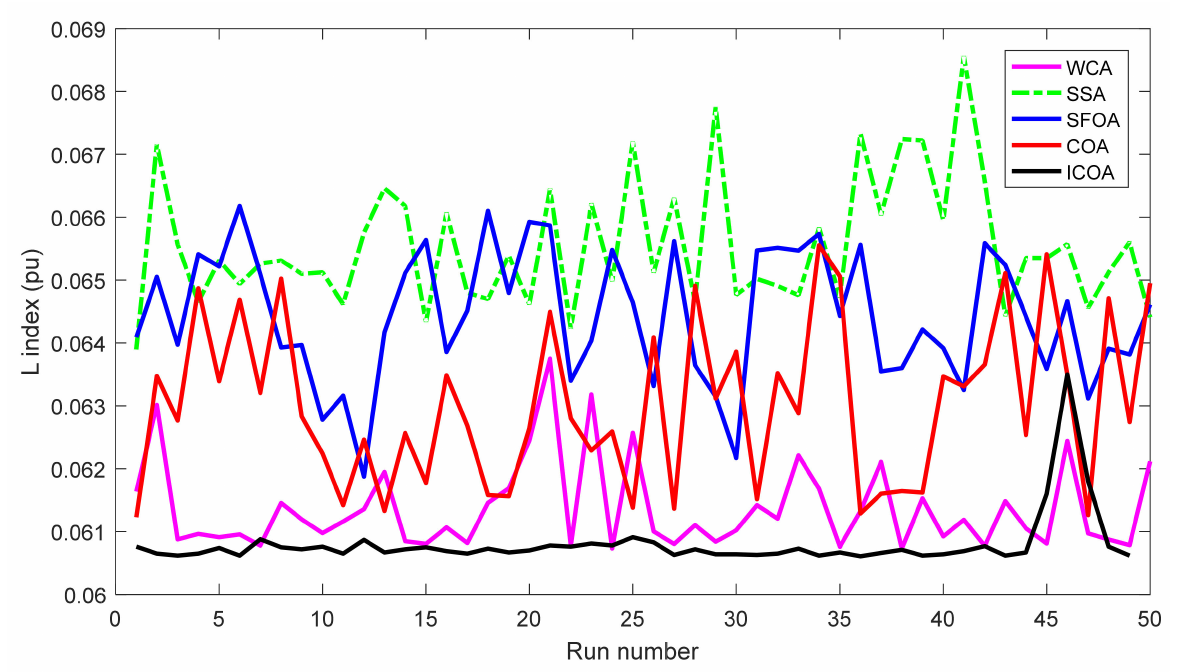
Figure 11. L index of 50 runs obtained by different methods for the IEEE 118-bus system.